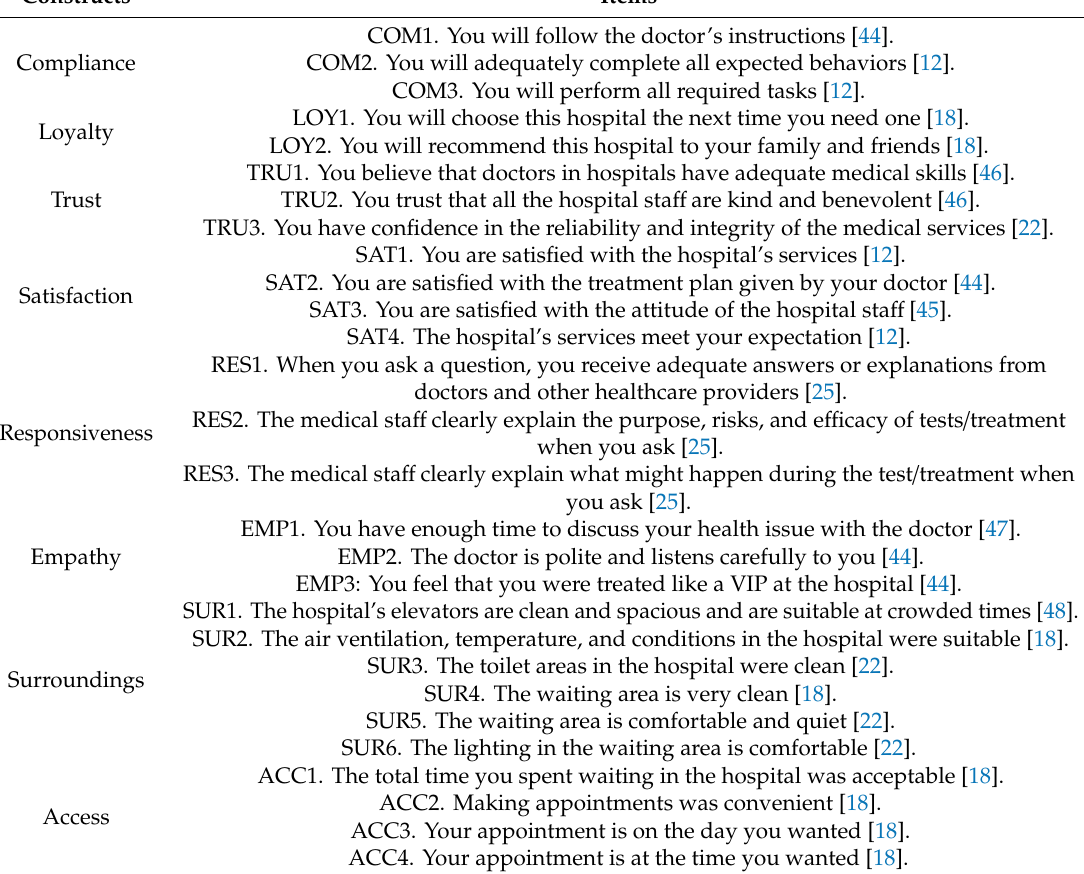
Table 2. Constructs and corresponding